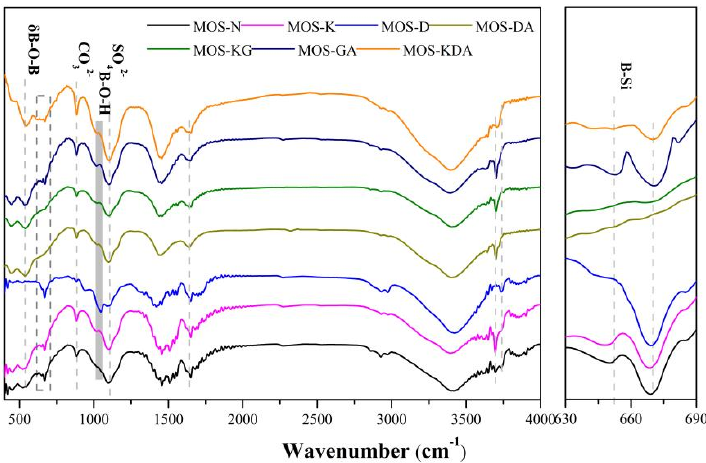
Figure 5. FTIR absorption spectra for control and mixed samples with different modifiers.